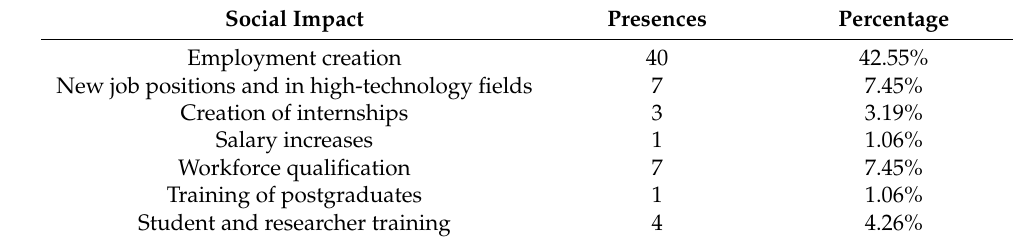
Figure A2. Social impacts of university–industry collaborations. Table A5. Social impacts of university–industry collaborations.